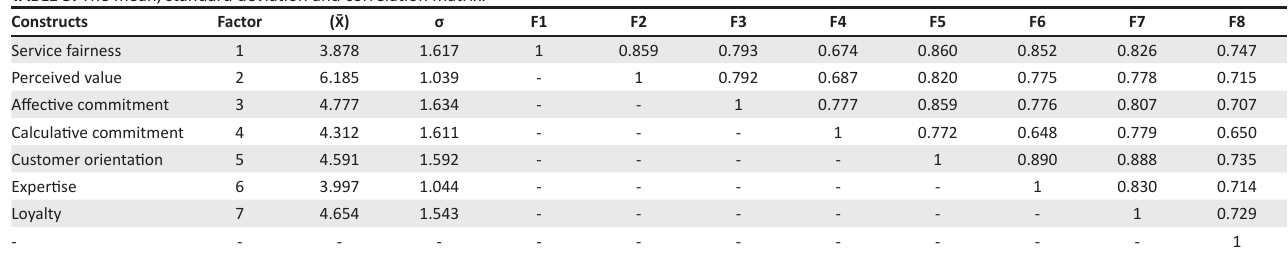
TABLE 3: The mean, standard deviation and correlation matrix. Constructs